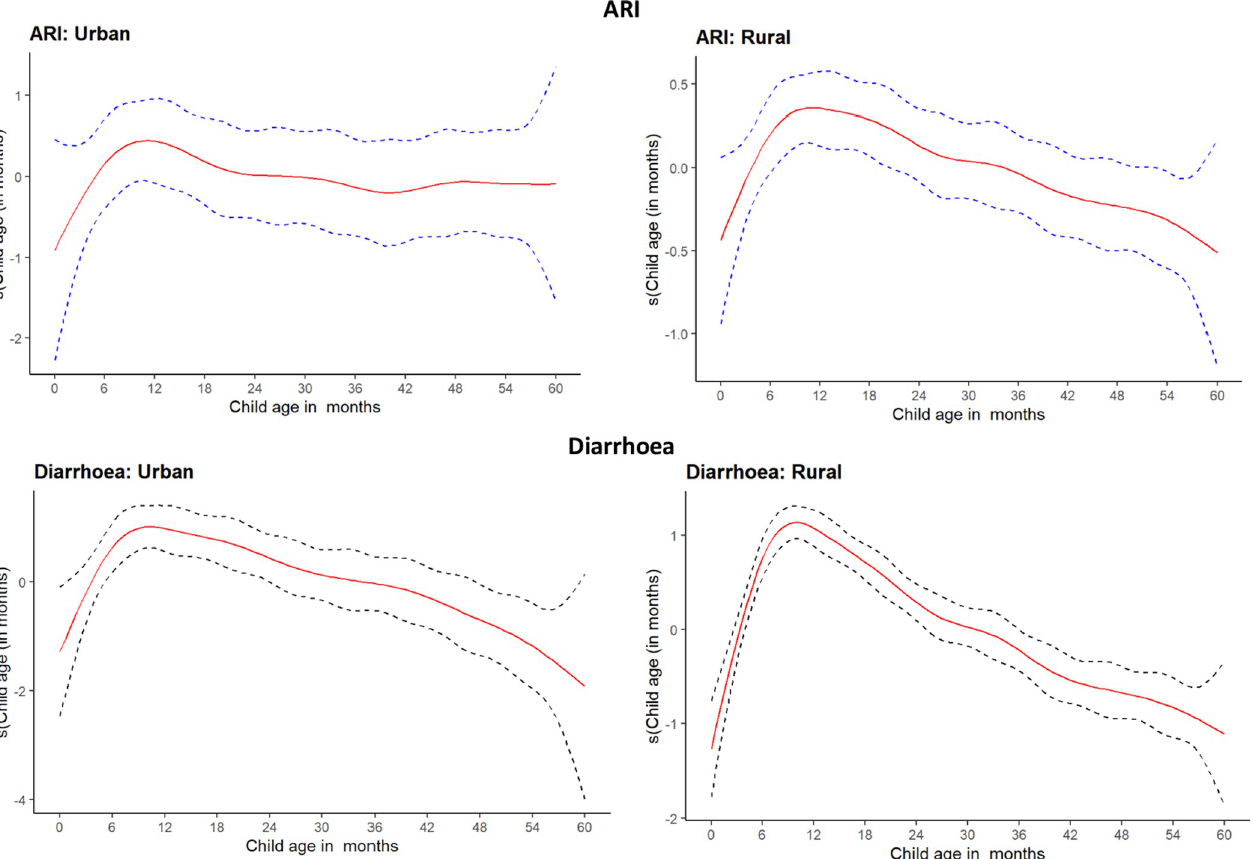
Fig 1. Assessment of the association of ARI and diarrhoea with children’s age.